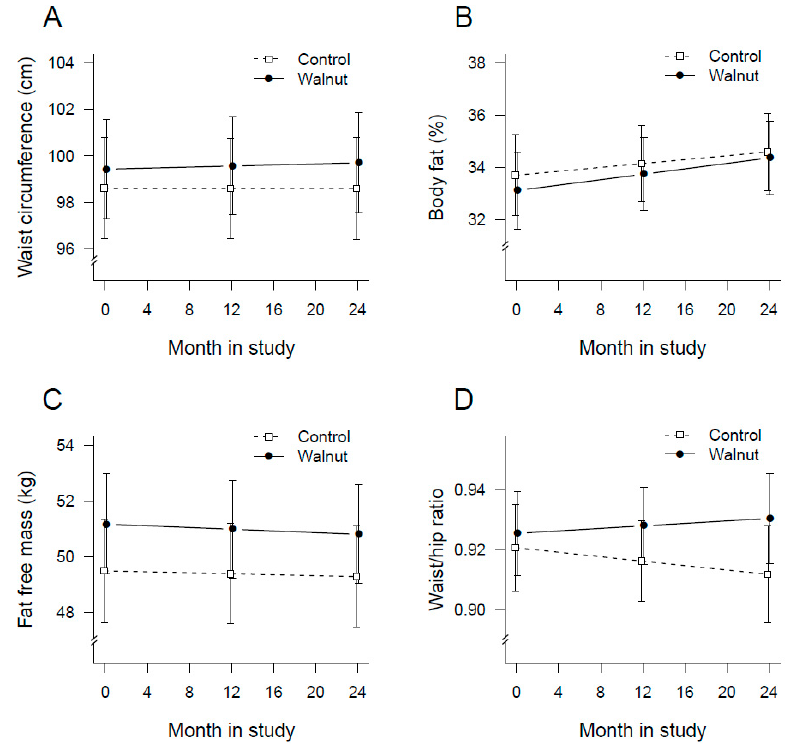
Figure 3. Plot of changes in mean waist circumference ( A ), body fat ( B ), lean body mass ( C ), and waist-to-hip ratio ( D ) over time by intervention group.